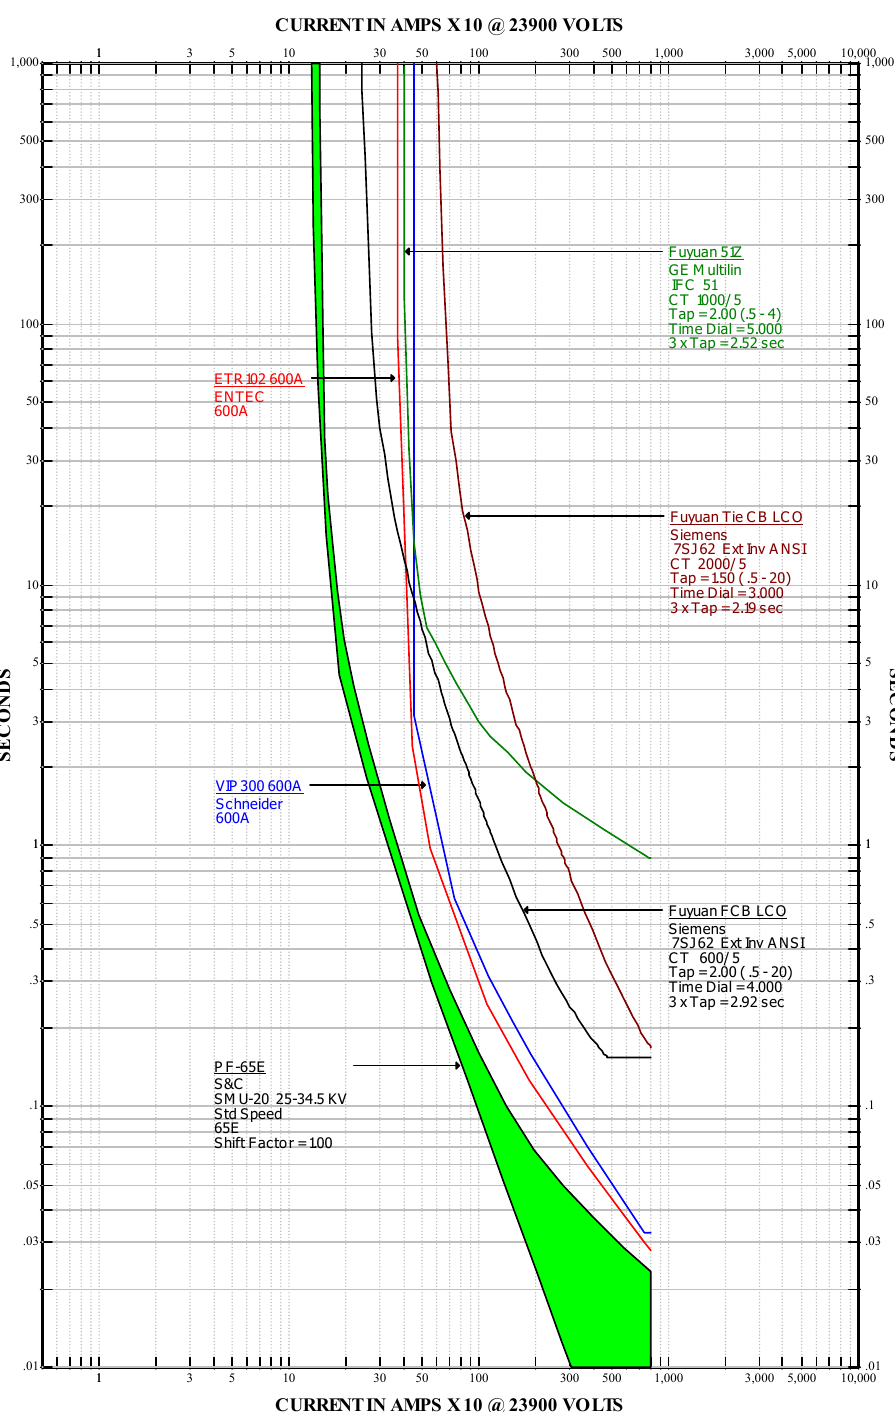
Figure 13. Original LCO relays of Fuyuan